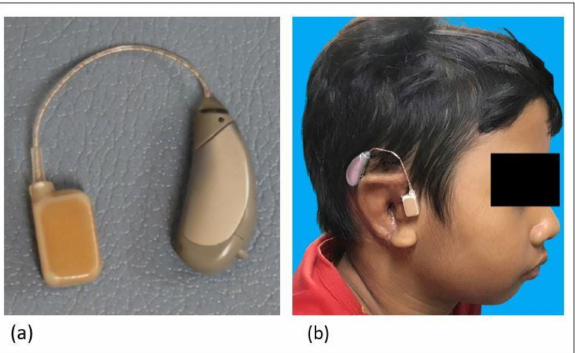
Figure 1. Cartilage conduction hearing aid ( a ) and the appearance of it on a patient ear ( b